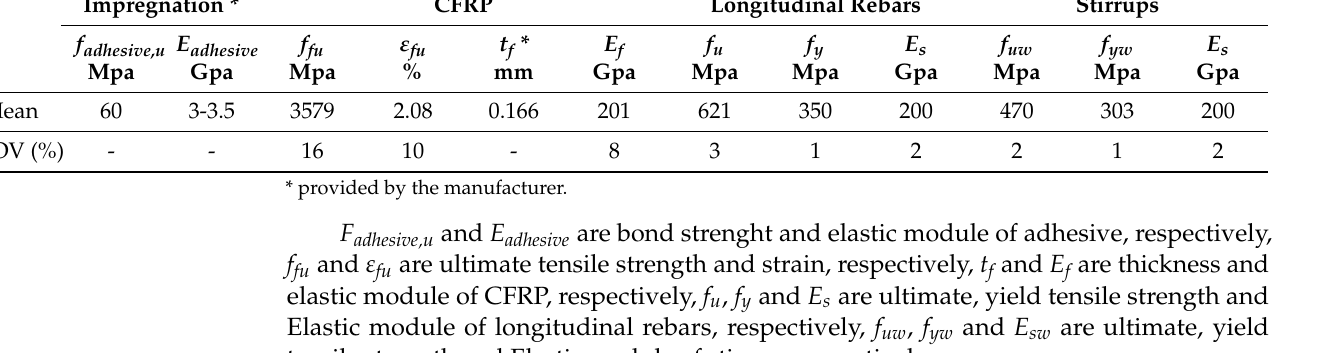
Figure 4. Procedure of strengthening with CFRP and curing.